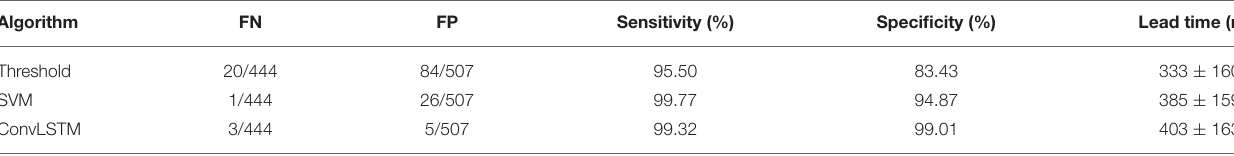
TABLE 3 | Overall performance of three benchmark algorithms on the testing set. Algorithm